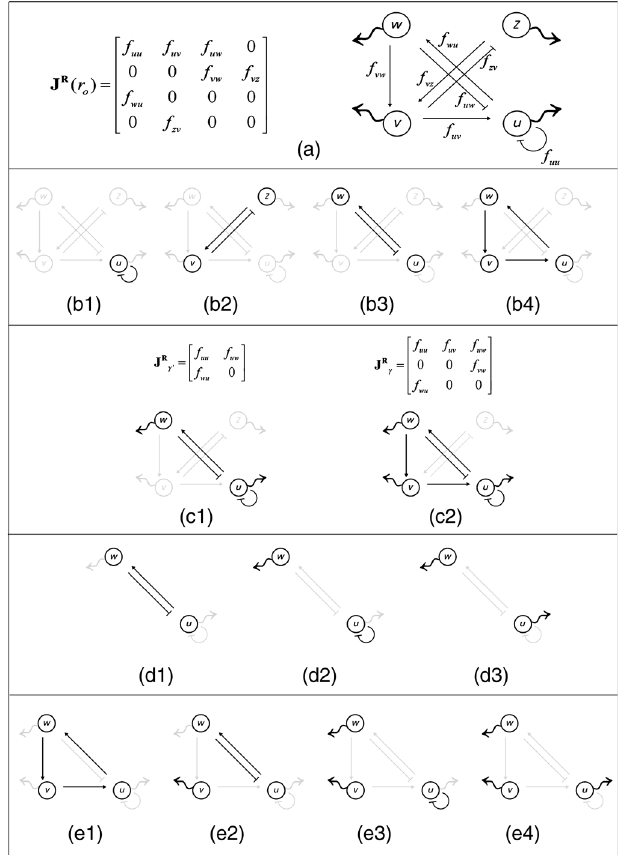
FIG. 7. (a) Jacobian of the reaction term and corresponding reaction-diffusion graph of a four-species Turing system. (b1) – (b4) Four reaction cycles contained in the graph: , ¼ f , , and ▵ · f · f . (c1), wu vw uv uwv (c2) Subgraphs induced by γ 0 ¼ ð u; w Þ and by γ ¼ ð u; v; w Þ , with the corresponding principal submatrices of J R shown above. (d1) – (d3) l -subgraphs contained in I γ ¼ð . (e1) – (e4) l -sub- R u;w Þ R graphs contained in I γ ¼ð . Graph components that do not form u;v;w Þ part of a subgraph are